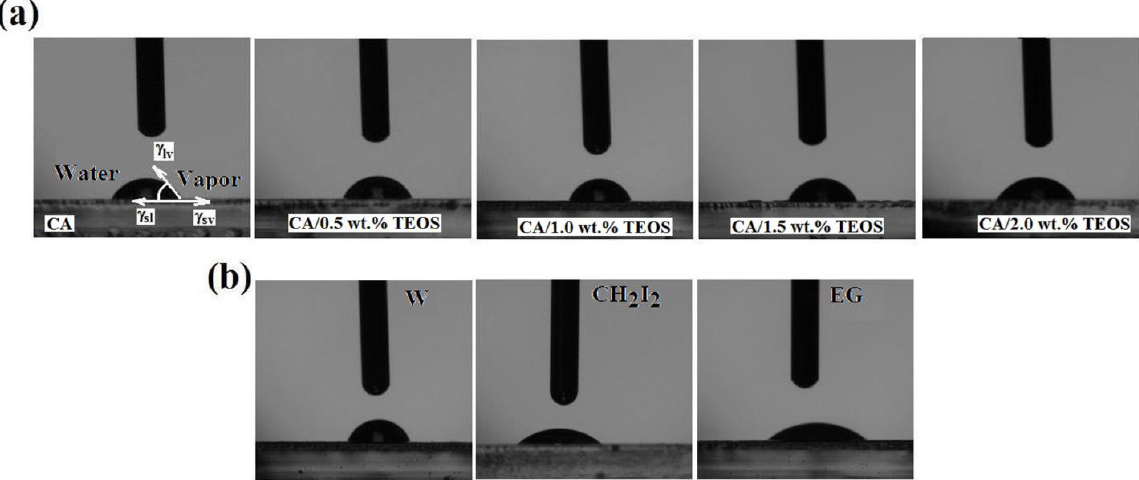
Figure 8. ( a ) Geometric configuration of water liquid droplets and the surface forces acting at the cellulose acetate/silica- water interface and ( b ) geometric configuration of used liquid droplets for CA+1 wt.% TEOS film.